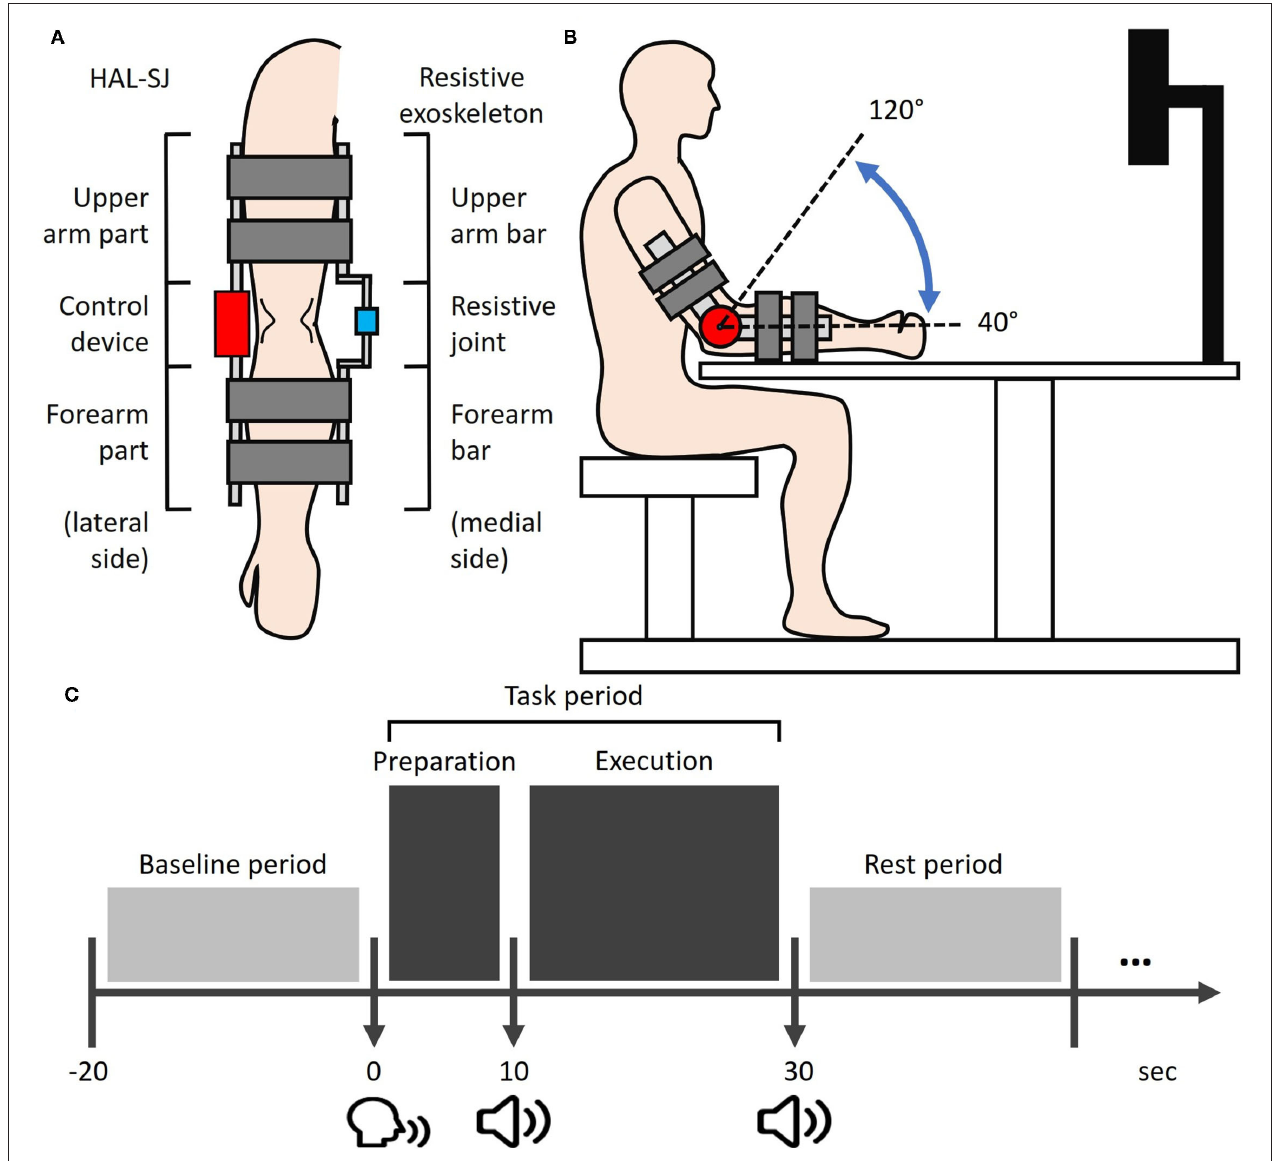
FIGURE 1 | Experimental setup. (A) The HAL-SJ and the resistance exoskeleton device are mounted on the lateral and medial sides of the right arm, respectively. (B) Experimental setup from a sagittal view. During the task execution phase, participants were required to perform cyclic elbow flexion-extension movements with the ROM from 40 to 120 ◦ (dash line). (C) The simplified schematic of the experimental trial protocol. Each task period was 30s long, including a 10-s preparation phase and a 20-s execution phase. The post-task period was pseudo-randomized between 20, 30, and 40s. HAL-SJ, single-joint version of the Hybrid Assistive Limb; ROM,